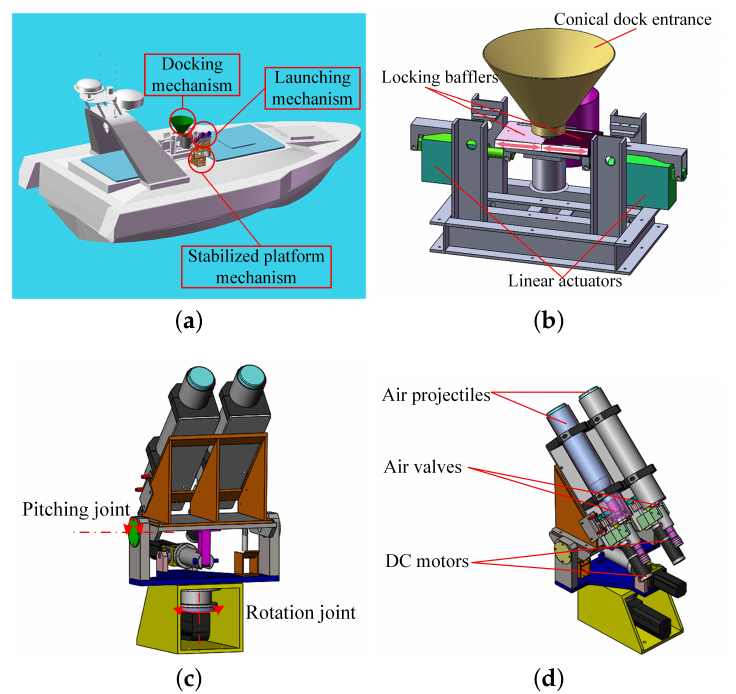
Figure 1. Schematic of an automated L&RS. ( a ) Concept. ( b ) Docking mechanism. ( c ) Stabilized platform mechanism. ( d ) Launching mechanism.